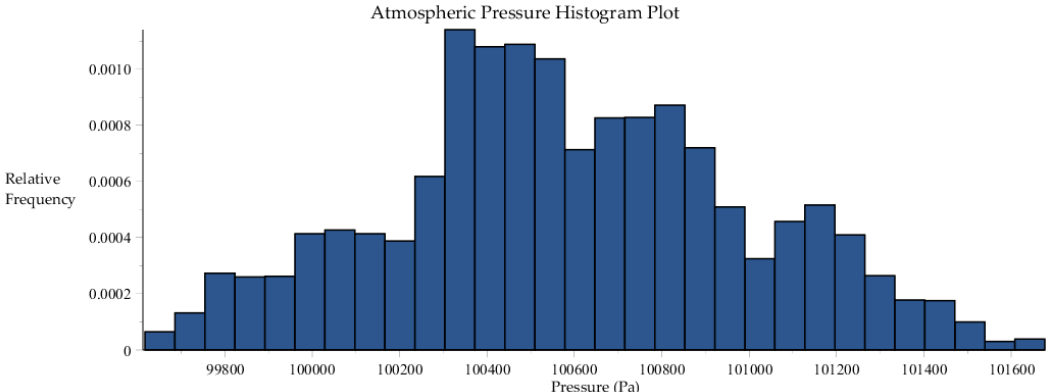
Figure B4. Histogram plot of atmospheric pressure data collected by SRNL from F-Area cooling towers.